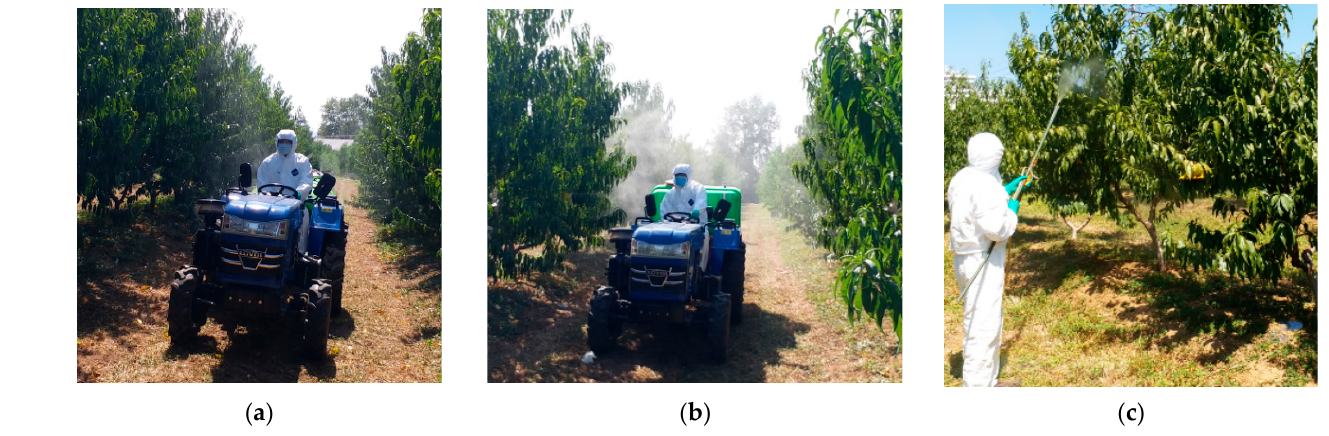
Figure 2. Photos of the sprayers in the peach orchard during the experiment. ( a ) Trailer air-assisted orchard sprayer, ( b ) mounted air-assisted orchard sprayer, ( c ) orchard spray gun. During the test, the operating distance, duration and application volume of each sprayer were accurately recorded, and the actual operating parameters of each sprayer were calculated. The specific operating parameters of the sprayers in the field test are shown in Table 1. Table 1. Operating parameters of the sprayers in the field test. Spraying